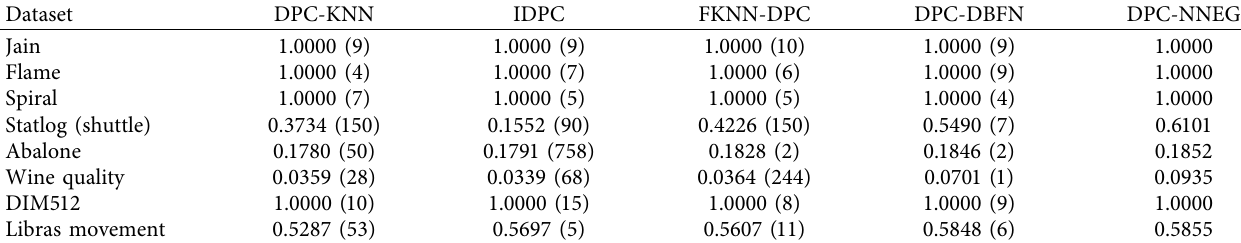
Table 3: Clustering results measured by NMI.